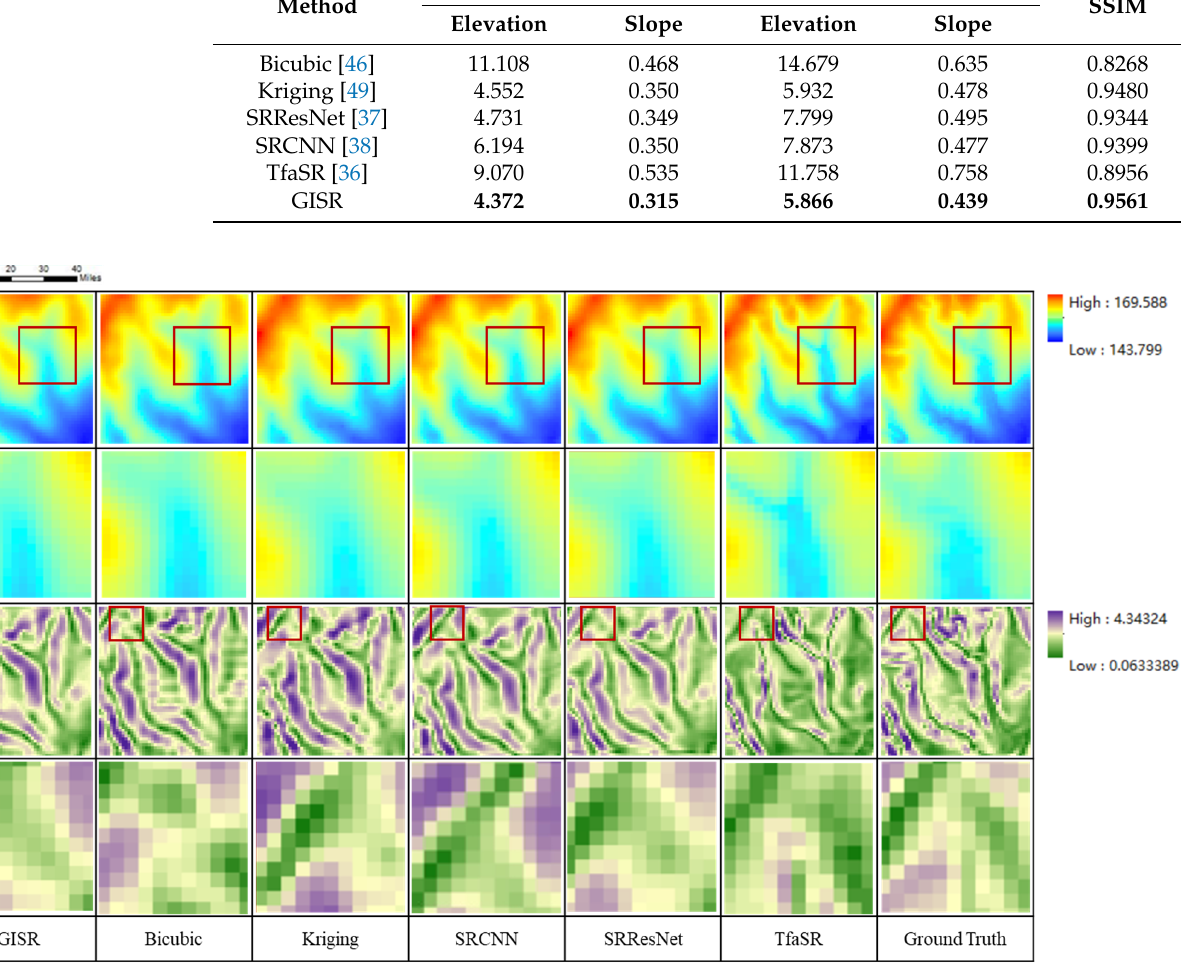
Figure 17. Results of different DEM SR methods on TfaSR dataset (The details in the red box are in the next row).